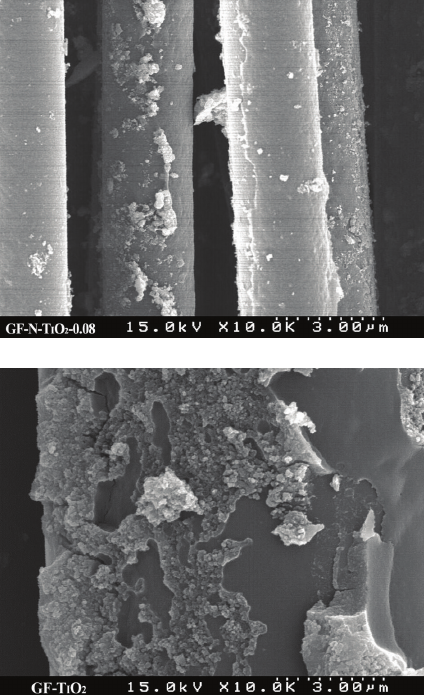
Figure 2: Scanning electron microscopy of GF-N-TiO 2 with a N-to- Ti ratio of 0.08 (GF-N-TiO 2 -0.08) and GF-TiO 2